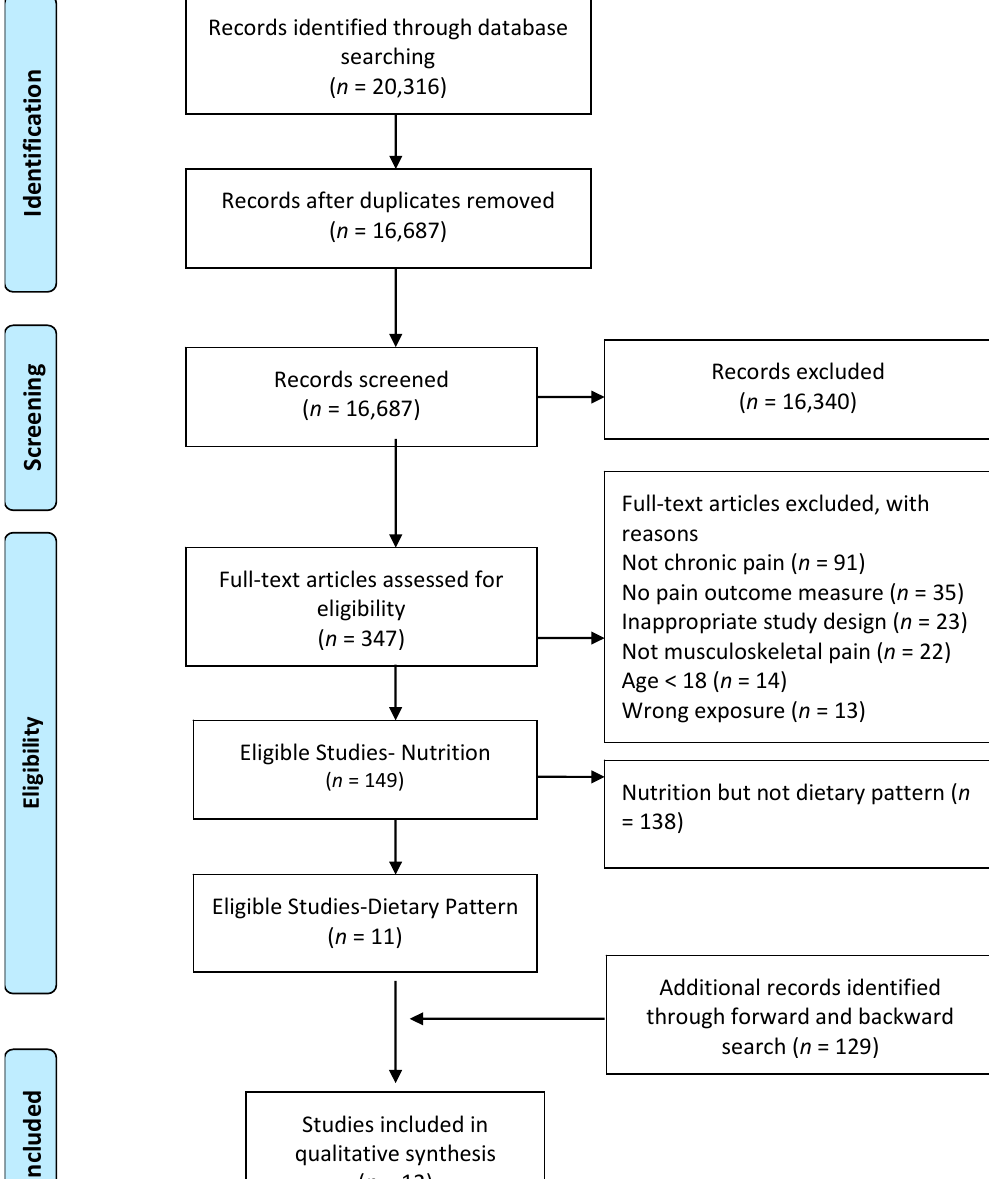
Figure 1. A flowchart giving a detailed overview of the study selection process.